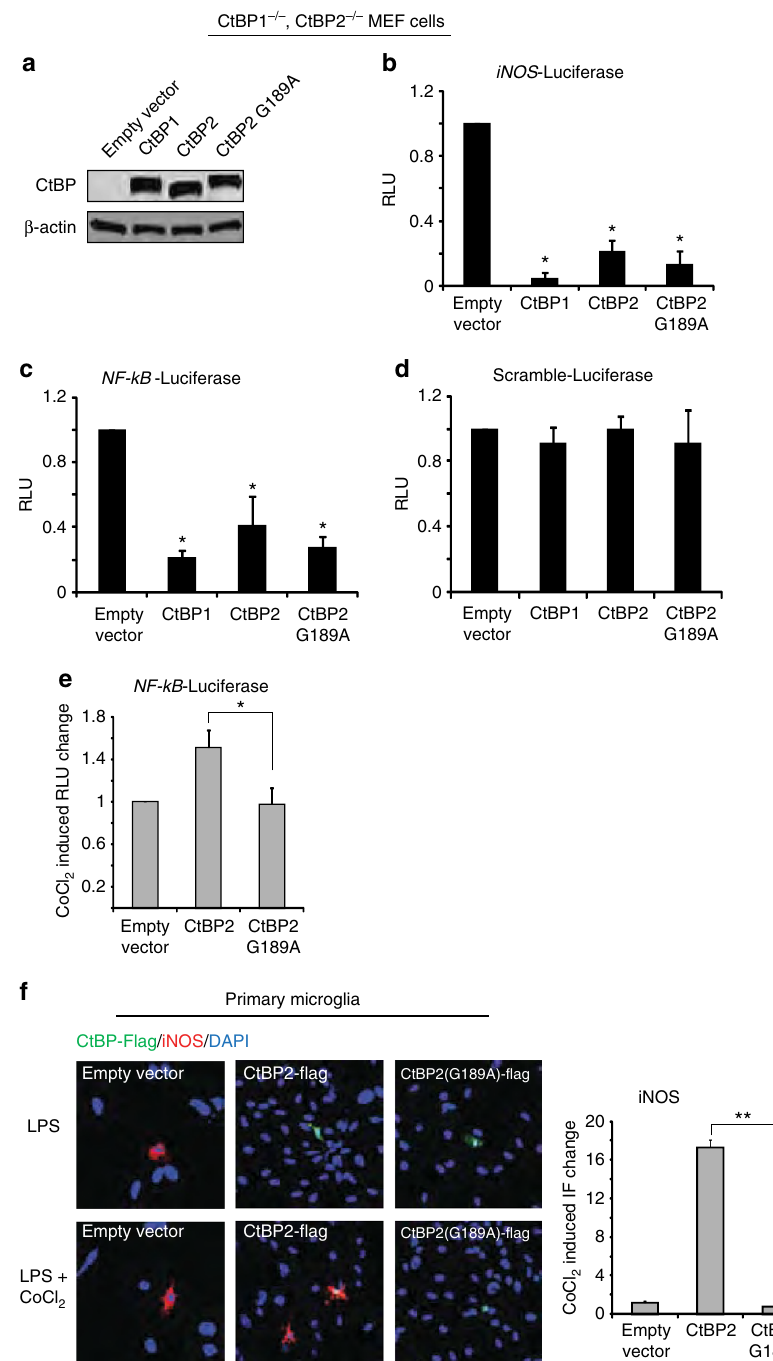
Fig. 6 The NAD(H) binding site on CtBP is required for its effect on in fl ammatory responses. a Transfection with CtBP1, CtBP2, and G1892 CtBP2 produced comparable expression levels in CtBP1 − / − /CtBP2 − / − MEF cells. Full length immunoblots are shown in Supplementary Fig. 3. b − d MEF cells were transfected with WT CtBP1, CtBP2 and G189A CtBP2, and additionally transfected with p65 to induce NF- κ B activation. All 3 CtBP constructs suppress iNOS and NF- κ B reporter gene transcriptional activity, and have no effect on a scrambled-sequence driven luciferase reporter gene. n = 3; * p < 0.05 v. empty vector. e The mitochondrial inhibitor CoCl 2 increased NF- κ B reporter gene activity in cells expressing WT CtBP2 but not in cells expressing G189A CtBP2. Results are normalized to the increase produced by CoCl 2 in the cells transfected with empty vector alone. n = 4; * p < 0.05. f Immunostaining in primary microglia shows LPS-induced iNOS expression is potentiated by CoCl 2 in cells transfected with WT CtBP2, but not G189A CtBP. Larger nuclei in the images belong to the astrocyte feeder layer. Results are normalized to the increase produced by 200 µ m CoCl 2 in the empty vector — transfected cells. n = 4; ** p < 0.01. Error bars show